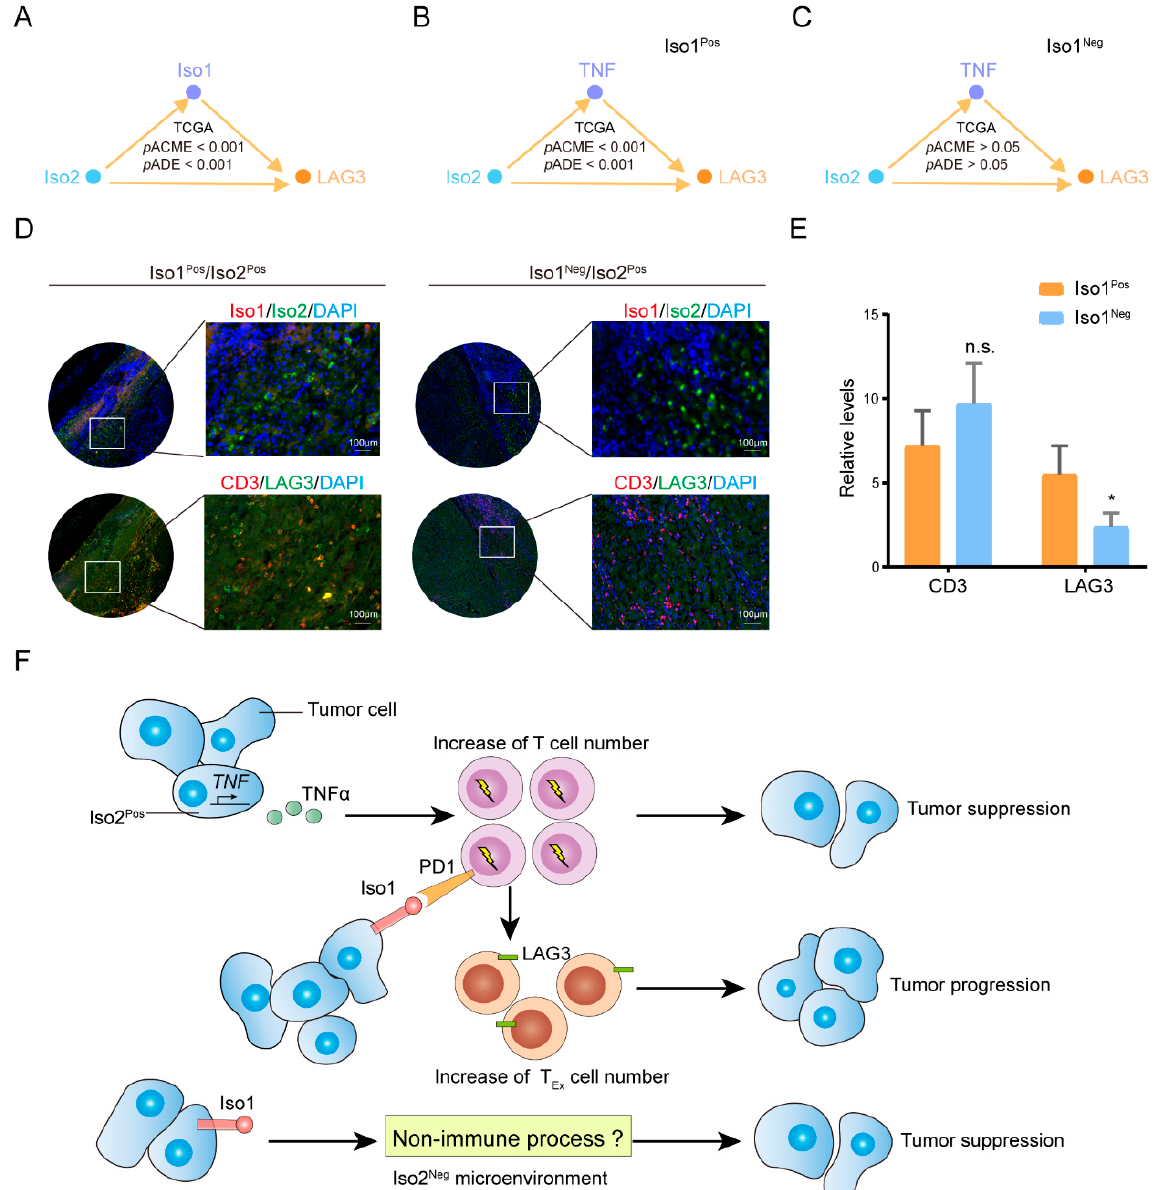
Figure 8. The roles of Iso1 in mediating the regulation of Iso2 on exhausted T cell. ( A – C ) The mediator analysis between LAG3 and Iso2. ( D , E ) The immunostaining of LAG3 + CD3 + T cells in Iso1 Pos Iso2 Pos and Iso1 Neg Iso2 Pos tumors. Data were presented as mean ± SD, n.s.: not significant, * p < 0.05. ( F ) Highlights of the results.